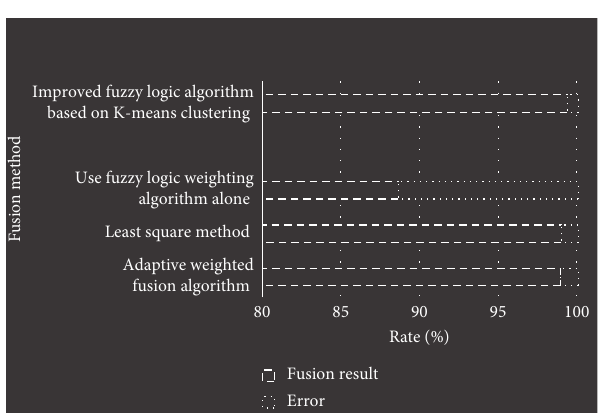
Figure 7: Comparison of different fusion algorithms.